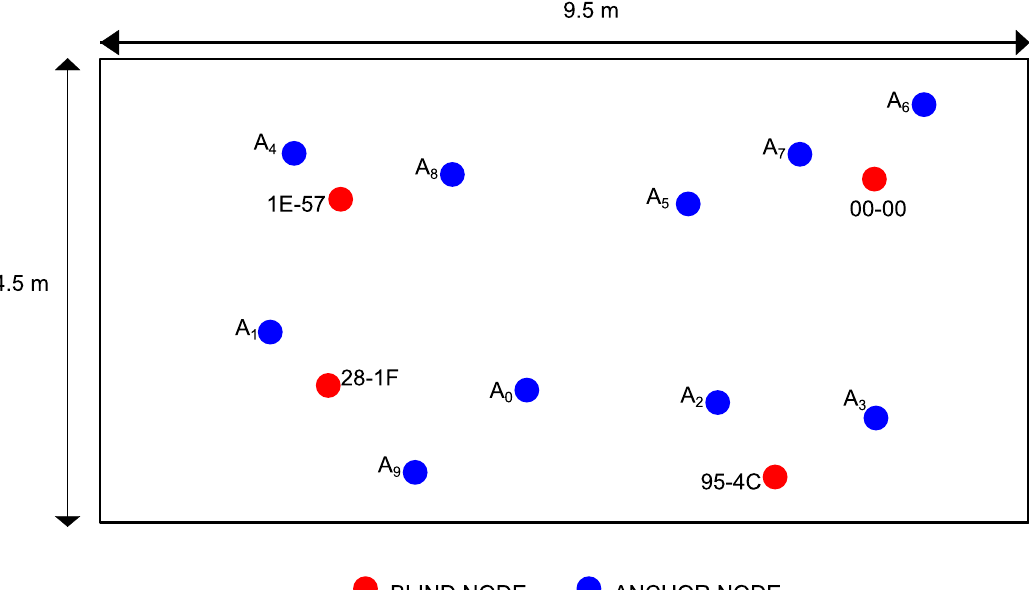
Figure 6. Position of the blind nodes and anchors for the